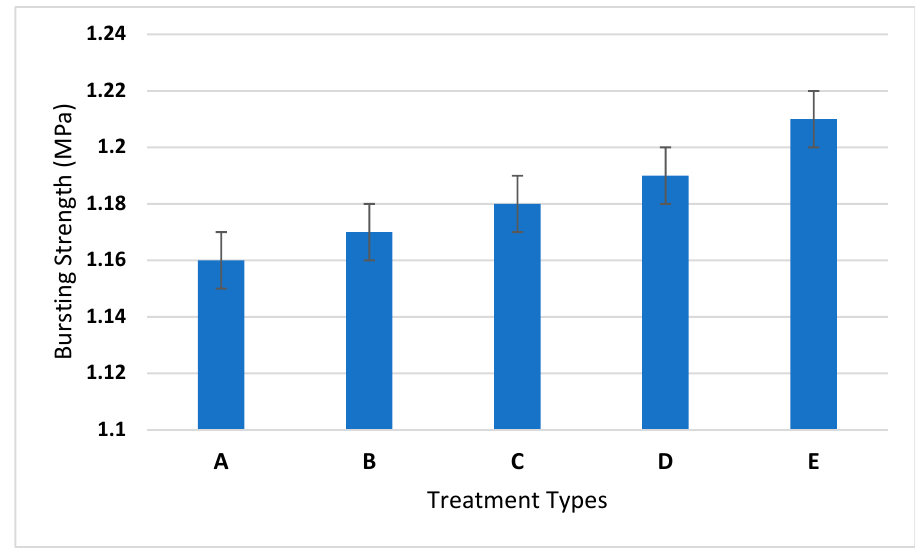
Figure 4. Effect of different finishes treatments on bursting strength (A) grey fabric, (B) simple wash, (C) normal finish, (D) silicon finish, and (E) wicking finish) .